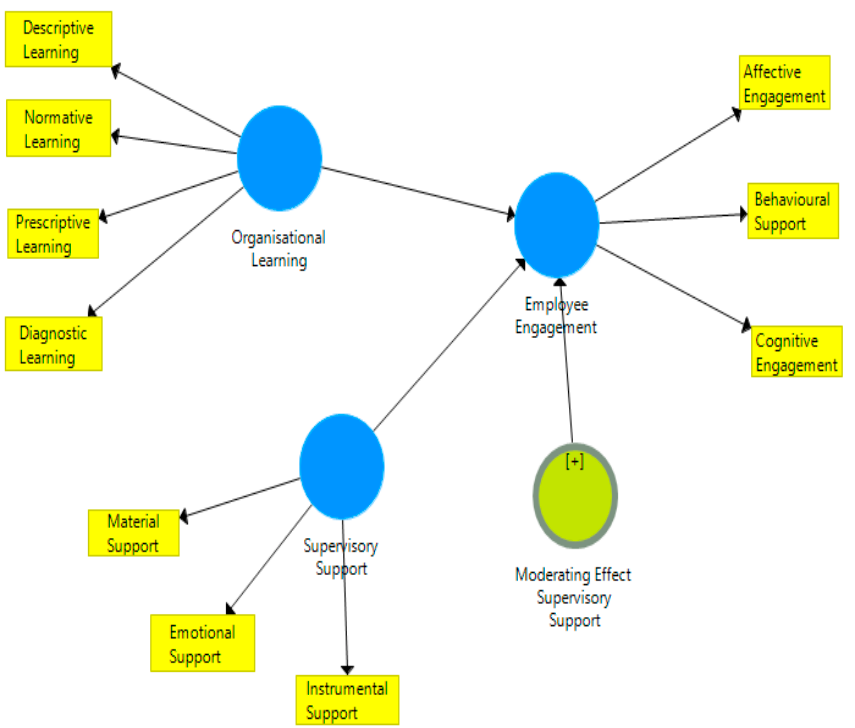
Figure 2. Organisational learning, supervisory innovative support and employee engagement